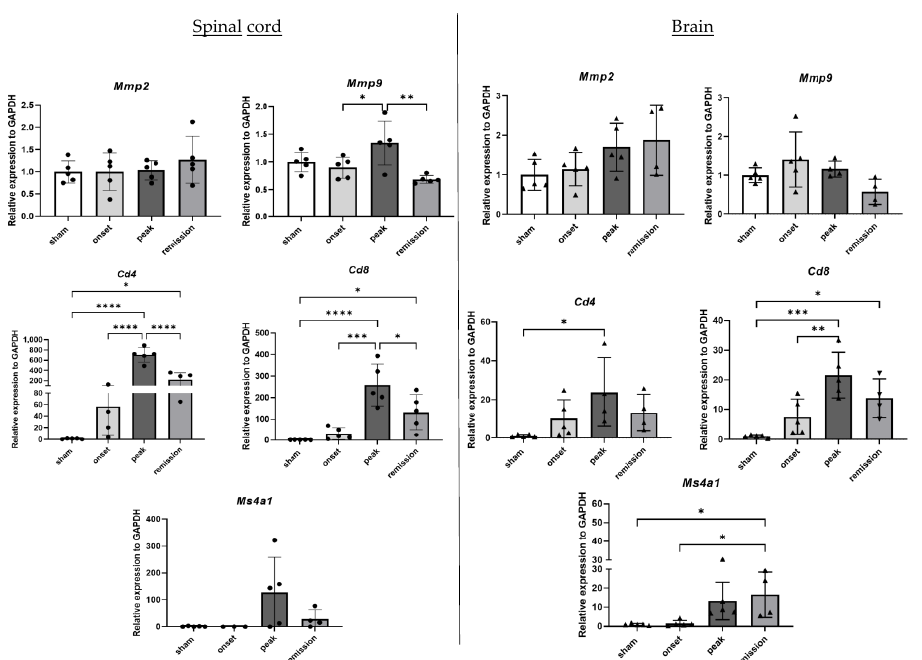
Figure 2. Differential expression of genes representative of BBB disruption in CNS organs during the different phases of PLP-induced EAE. The levels of mRNA transcripts for the selected genes relative to Gapdh were measured in the spinal cord ( left ) and brain ( right ) samples isolated from adjuvant controls and EAE mice on the onset, peak, and remission phases by RT-qPCR. A number of 3 to 5 mice was used in the experiment. Each symbol represents a sample. * p < 0.05, ** p < 0.01, *** p < 0.001, **** p < 0.0001, one-way ANOVA. Gliosis was studied using GFAP and GLAST (coded by the gene Slc1a3 ). Interest- ingly, even though gene expression of Slc1a3 levels did not differ between the groups, Gfap expression is particularly increased in the EAE condition in the spinal cord samples. Its expression increases gradually until the peak of the disease, and its levels remain ele- vated even during the remission phase for both brain and spinal cord samples (Figure 3).